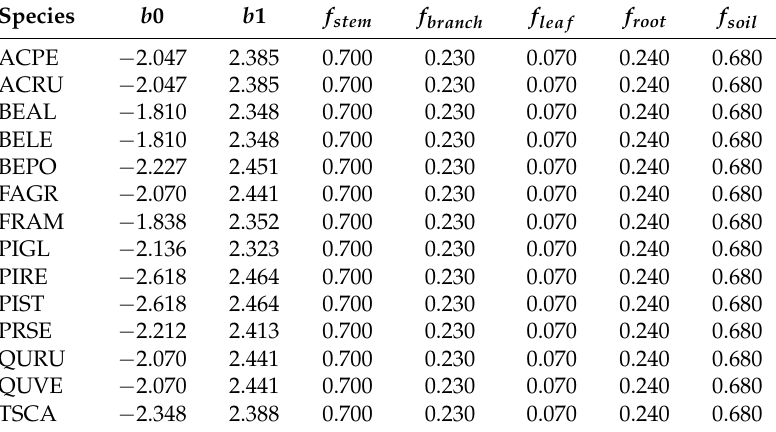
Table A2. Species biomass equation parameters.